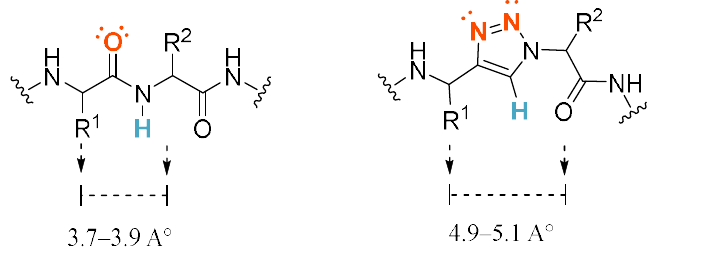
Figure 2. 1,2,3-triazoles 1-4-disubstitutes as an isostere of trans -amide bonds.